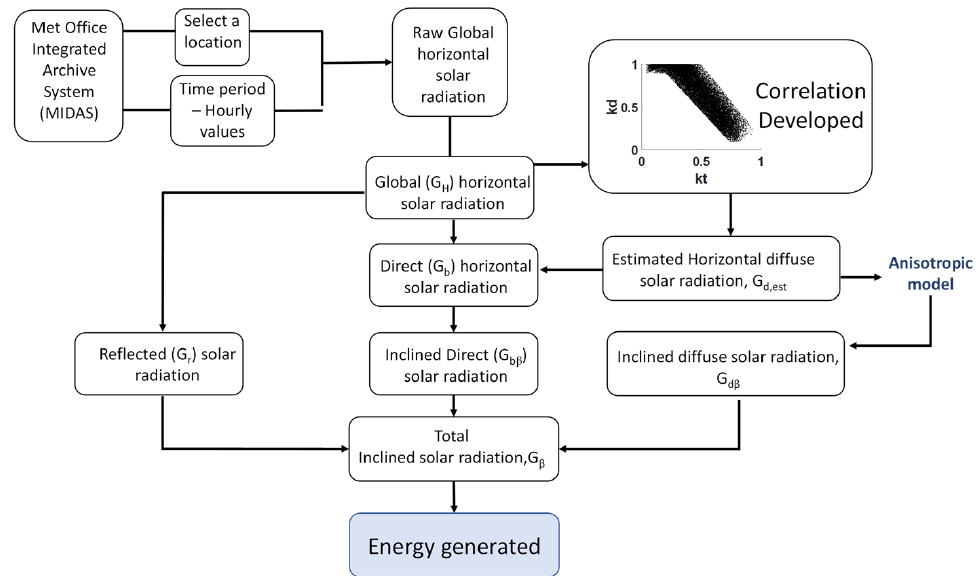
measured at a weather station located in Walnatt (Nottinghamshire, UK) between 2009 and 2019 in kJ/m 2 . The values of global solar irradiation were then averaged and transformed into kWh/m 2 to be used as input to the solar model. The datasets correspond to hourly measurements of horizontal global solar irradiation (G H ). Empirical correlations were used to estimate values of horizontal diffuse solar radiation (G d,est ) [43].